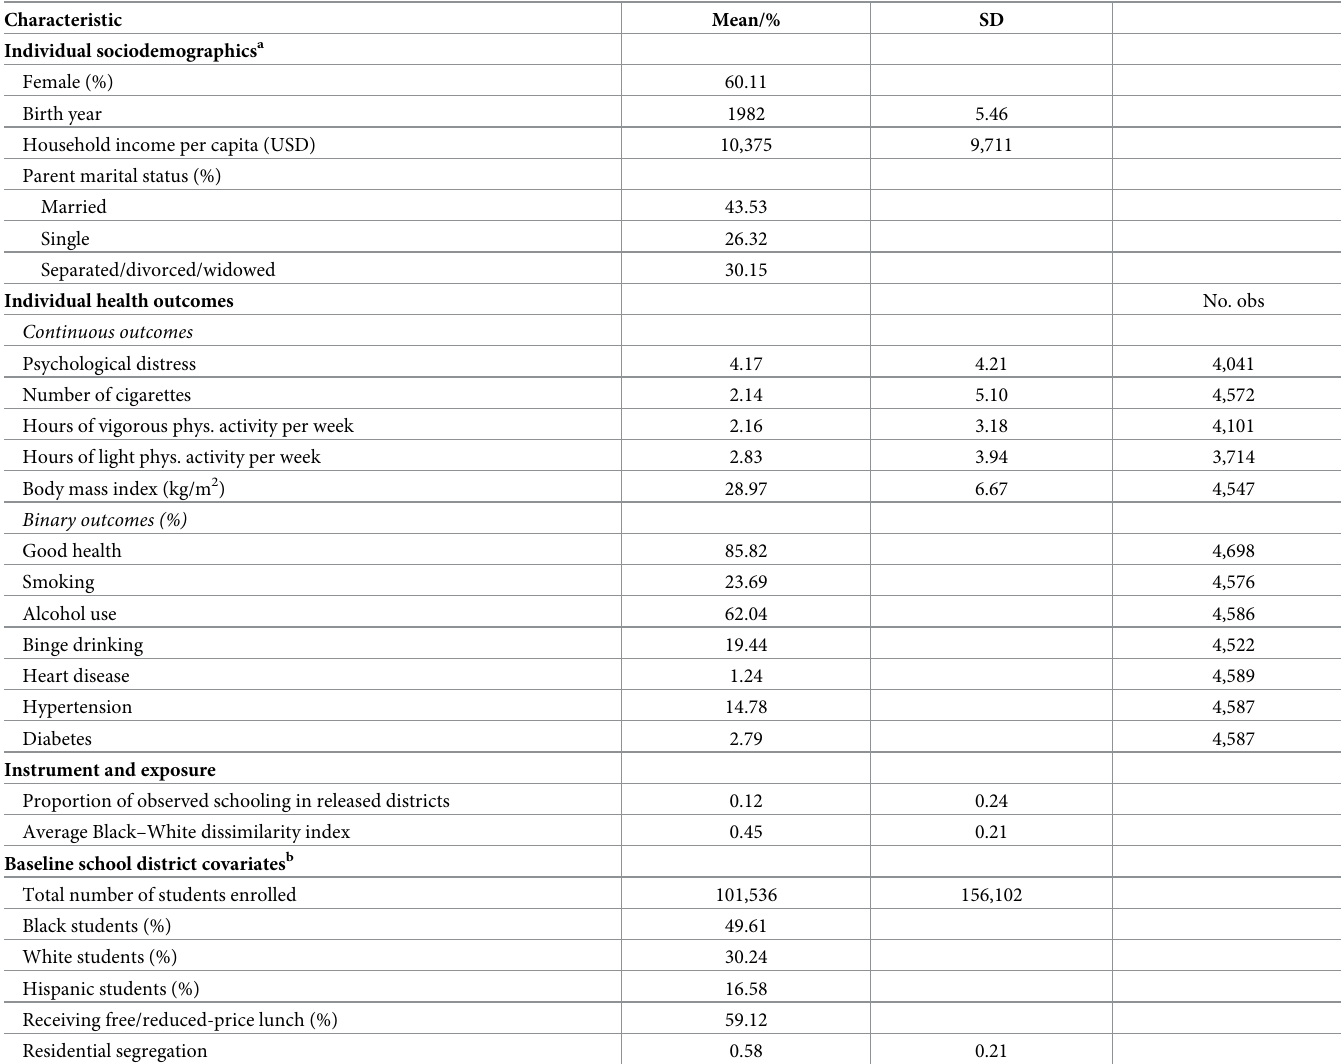
Table 1. Sample characteristics, Panel Study of Income Dynamics,